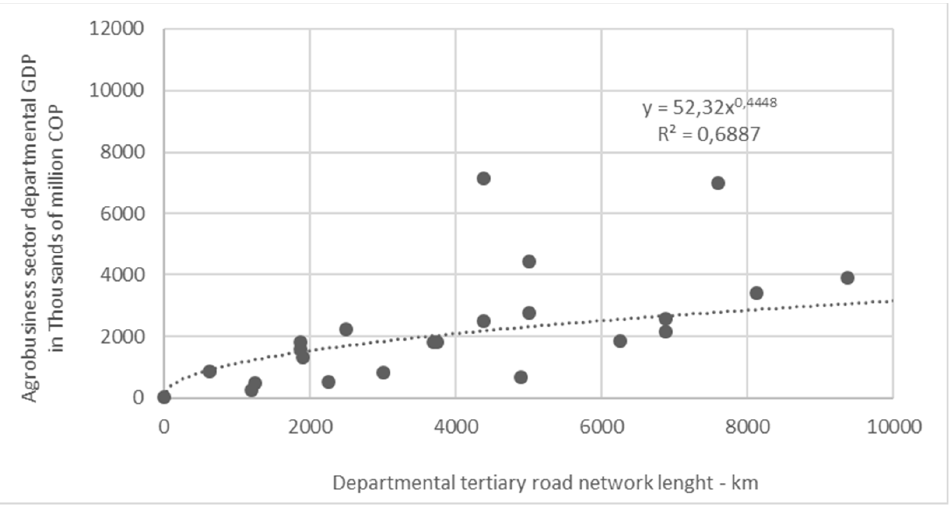
Figure 6. Potential regression between agribusiness GDP and tertiary roadway network length, according to the department.